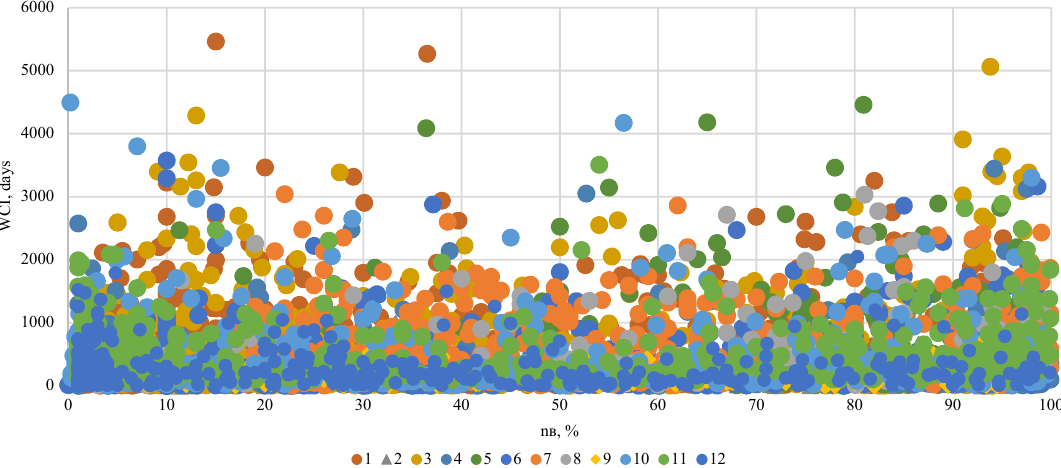
Figure 6. Changes in the WCI coefficient depending on the well water cutting (number in the key are IDs for the oil and gas production workshops).